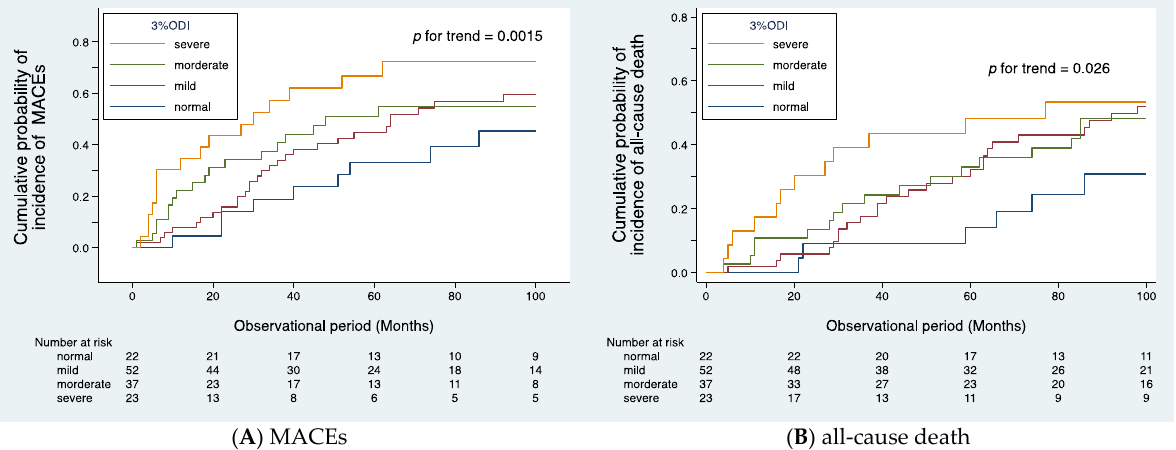
Figure 2. Cumulative probability of incidence of cardiovascular events ( A ) and all ‐ cause death ( B ) according to the severity of SDB. Kaplan–Meier analysis revealed that the patients in the severe group had a higher frequency of cardiovascular events ( p for trend = 0.0015, ( A )) and all ‐ cause death ( p for trend = 0.026, ( B )). Table 2. Multivariable Cox regression analysis for (A) MACEs and (B) all ‐ cause mortality according to SDB severity.